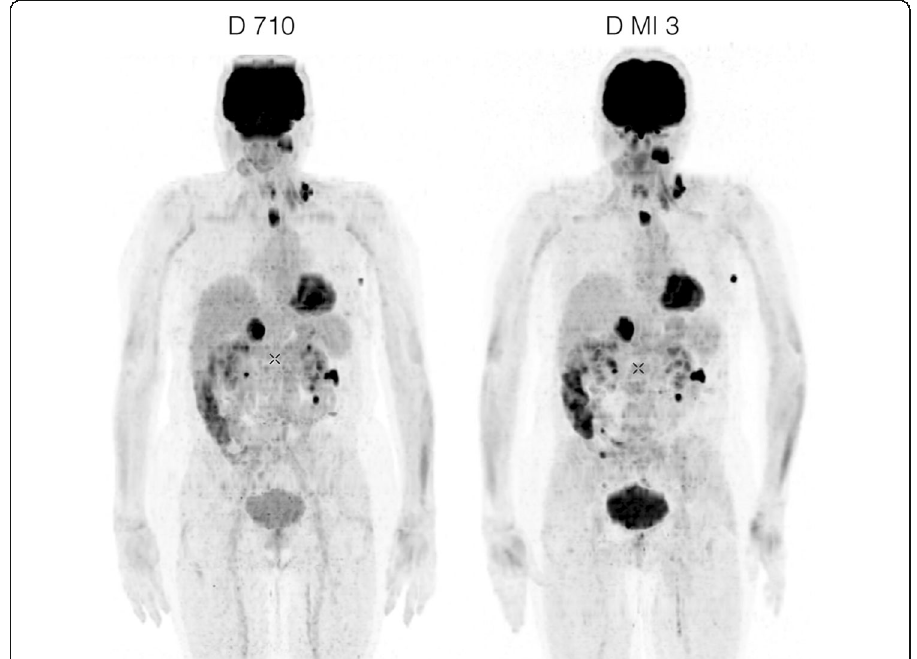
Fig. 8 Maximal intensity projection images. These were obtained in a melanoma patient on a Discovery 710 PET/CT (left panel) and, after one half-life radioactive decay, on a Discovery MI 3 PET/CT (right panel), using the same acquisition parameters. Image reconstruction by the Q.Clear algorithm used a beta value of 400 for the Discovery 710 acquisition and 1000 for the MI 3 acquisition. All lesions visible on the Discovery 710 study are visible on the Discovery MI 3 study as